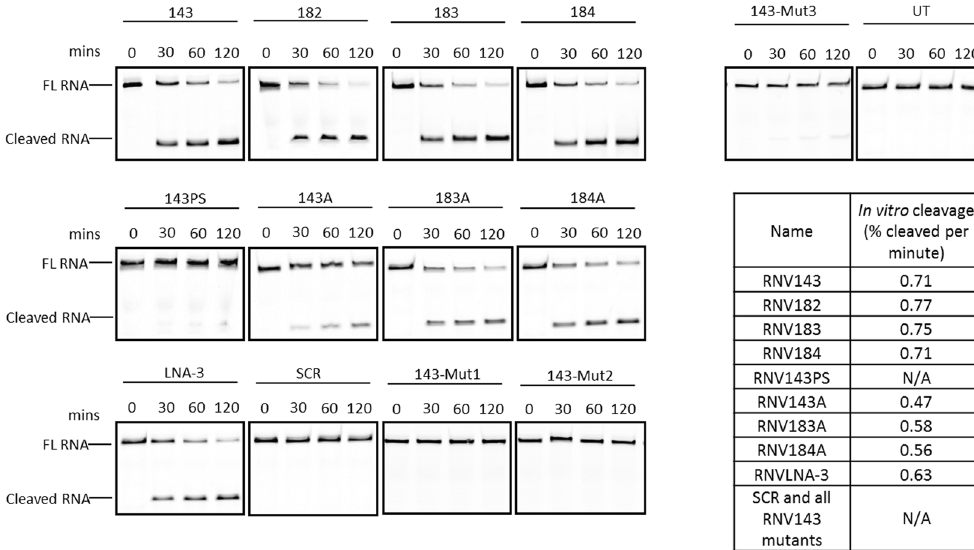
Figure 4. In vitro cleavage of the FAM-conjugated ITGA4 RNA template composed of exon 9 region (34 nucleotides) by RNV143 and its derivatives. FL RNA, full length; FAM-conjugated RNA; cleaved RNA; the cleaved FAM-conjugated ITGA4 RNA (18 nucleotides long). The FAM- conjugated template RNA is a small region of the ITGA4 transcript complementary to the hybridisation arms of the DNAzymes of interest. The gel images were cropped for better overview. The original images are shown in Figure S3 (Supplementary Information). The table shows the cleavage rate in %/min which was calculated as described in Materials and Methods